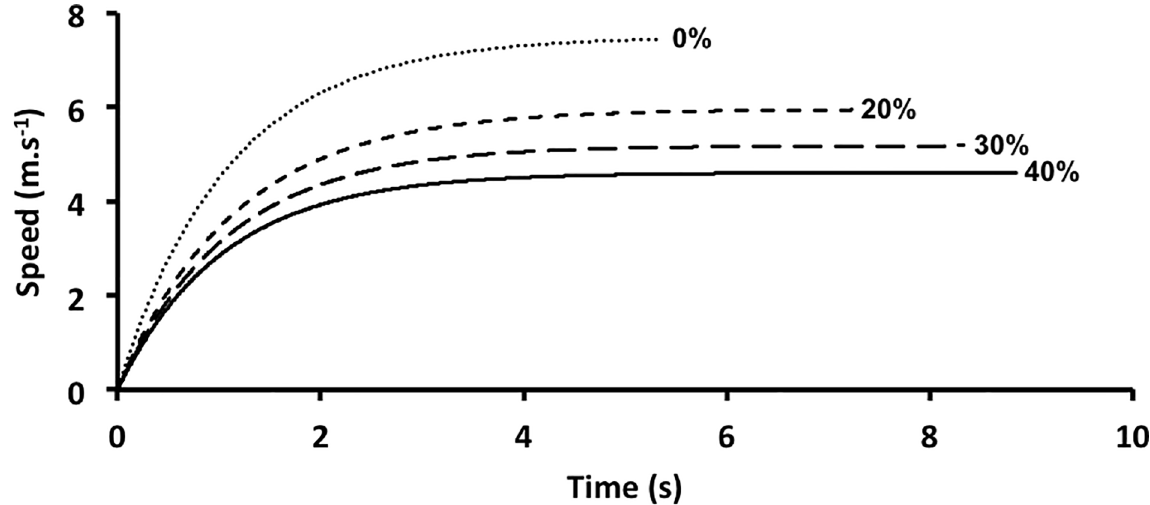
Fig 1. Horizontal velocity and acceleration as a function of time during a sprint acceleration phase, for each condition (percent of body mass). These data are from one representative individual.